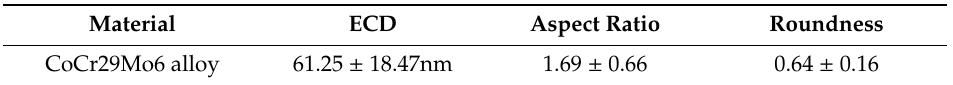
Table 1. Morphological parameters of particles. The CoCr29Mo6 particle shape is predominantly oval and round with a small proportion of acicular particles (shape: round, 44%; oval, 49%; needle, 7%). Equivalent circular diameter (ECD).